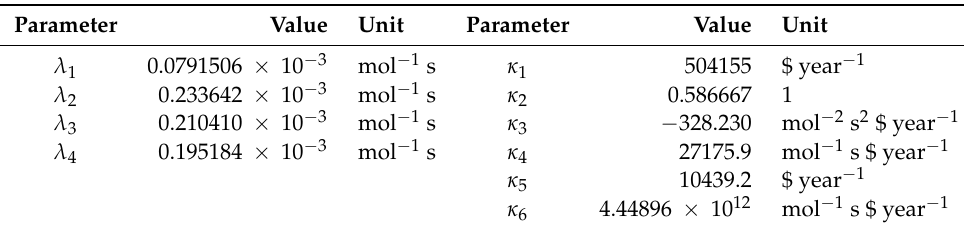
Table 2. Cost function